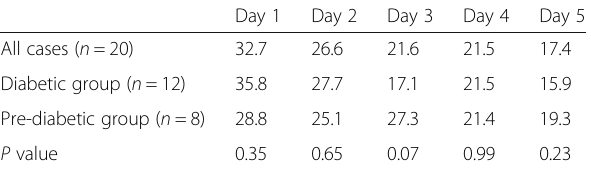
Table 2 Mean amplitude of the fluctuation in glucose concentration in the diabetic and pre-diabetic groups Day 1 Day 2 Day 3 Day 4 Day 5 All cases ( n = 20) 32.7 Diabetic group ( n = 12) 35.8 Pre-diabetic group ( n = 8) 28.8 0.35